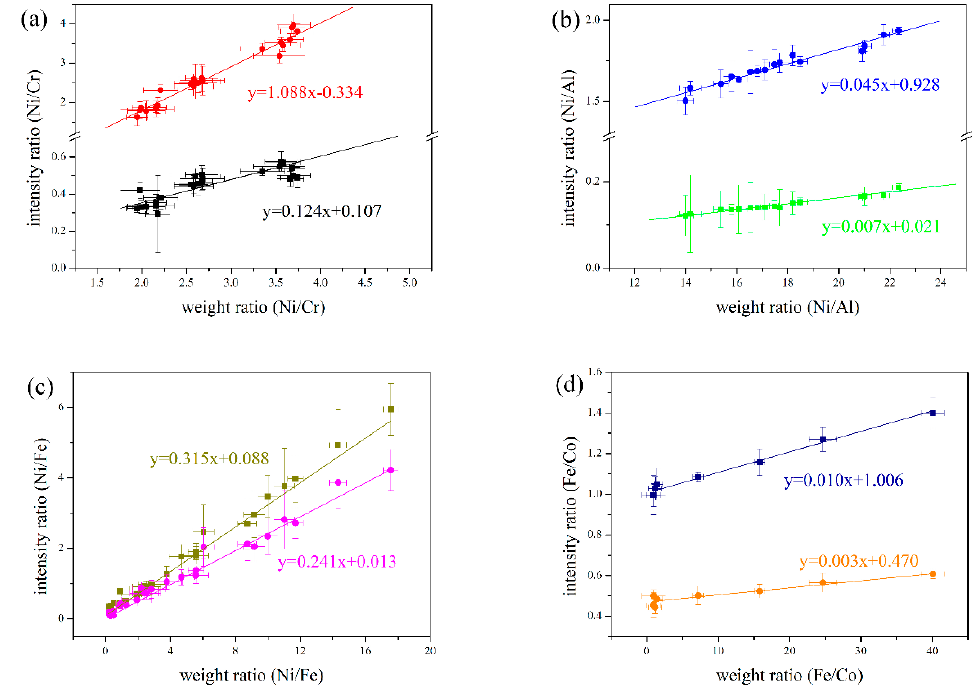
Figure 10. Calibration curves for different elements. ( a ) Ni I 352.454/Cr I 357.869 ‐ red, Ni I 385.830/Cr I 360.533 ‐ black; ( b ) Ni I 352.454/Al I 394.401 ‐ blue, Ni 357.186/Al I 396.152 ‐ green; ( c ) Ni I361.274/Fe I 387.250 ‐ olive, Ni I 356.637/Fe I 387.250 ‐ purple; and ( d ) Fe I 387.25/Co I 411.877 ‐ navy, Fe I 361.877/Co I 411.877 ‐ orange.